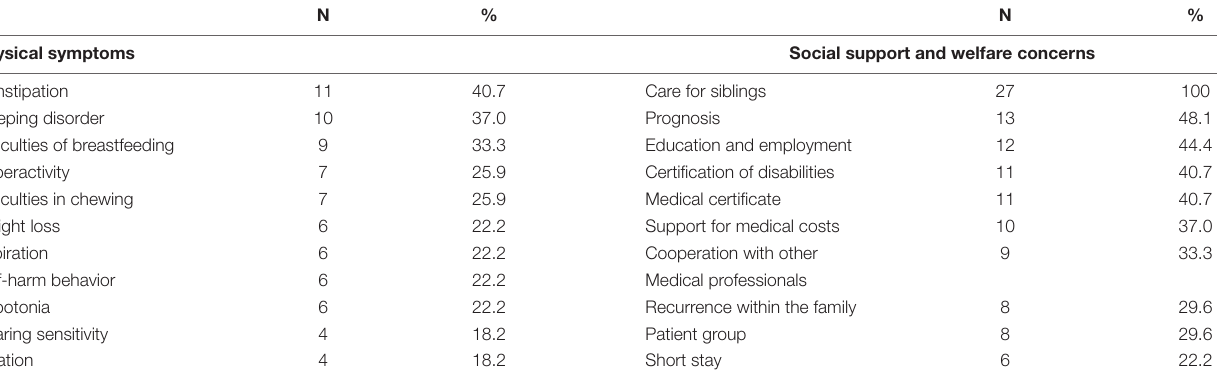
TABLE 1 | Physical symptoms and social support and welfare concerns of patients with 5p- syndrome according to healthcare professionals ( N < 27, multiple answer). N % N